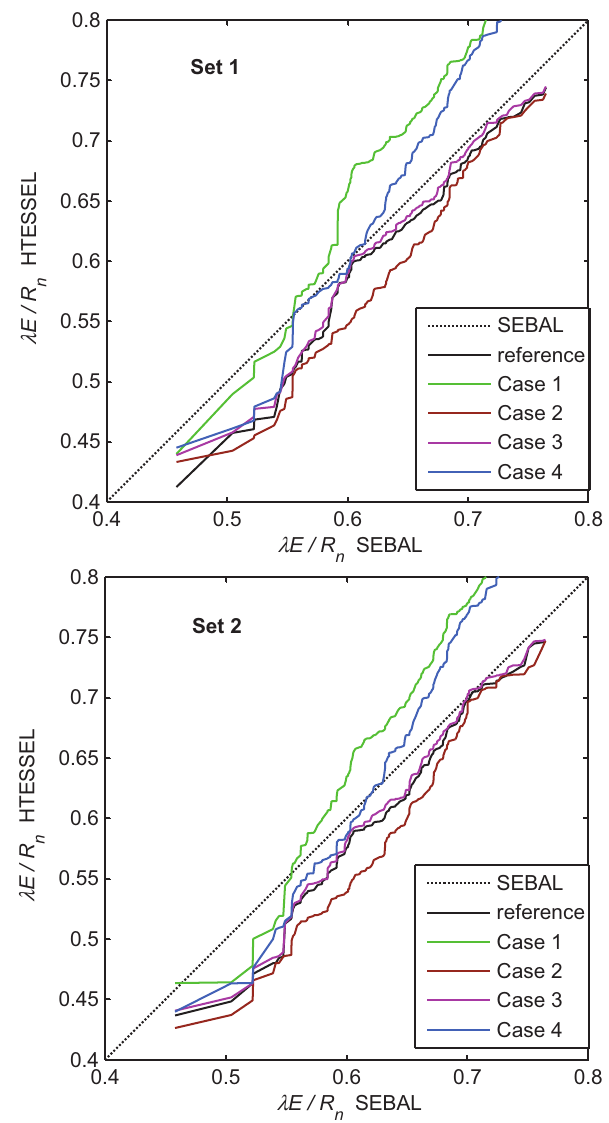
Fig. 15. Seasonally averaged ranked SEBAL λE / R n plotted against ranked HTESSEL λE / R n for all grid cells in the test region for: (a) initial condition Set 1 that refers to an initial soil state variable condition set and (b) initial condition Set 2 that refers to equilibrium of state variables over 2005. λE / R n has been calculated by using the λE and R n over 30 weeks starting at week